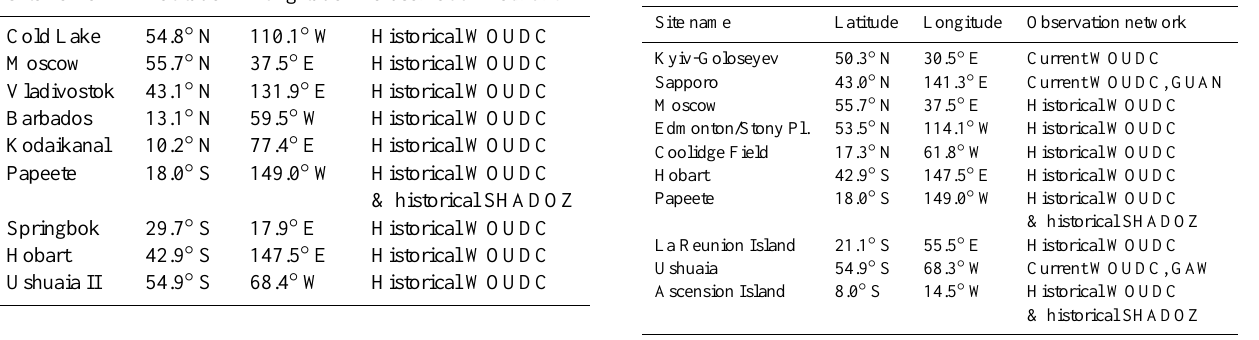
Table 5. The five most frequently selected Northern Hemisphere sites in the 31 sets of optimal sites followed by the five most fre- quently selected Southern Hemisphere